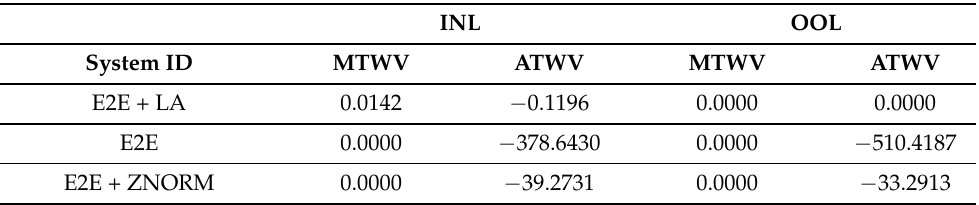
Table 26. System results of the QbE STD task for MAVIR test data for in-vocabulary (INV) and out-of-vocabulary (OOV) queries.